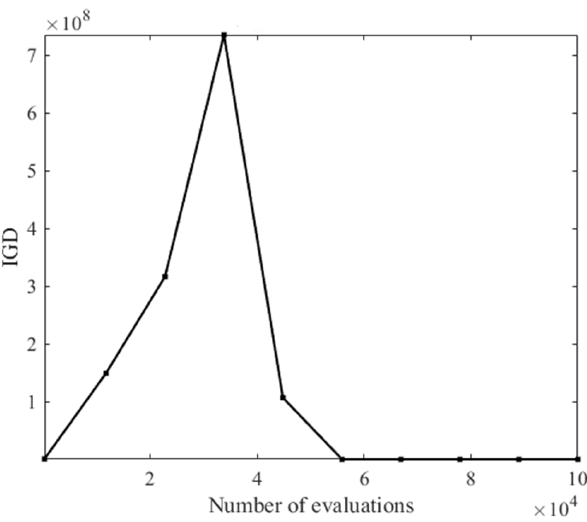
Figure 5. Change of IGD value with the number of assessments (15 objective).